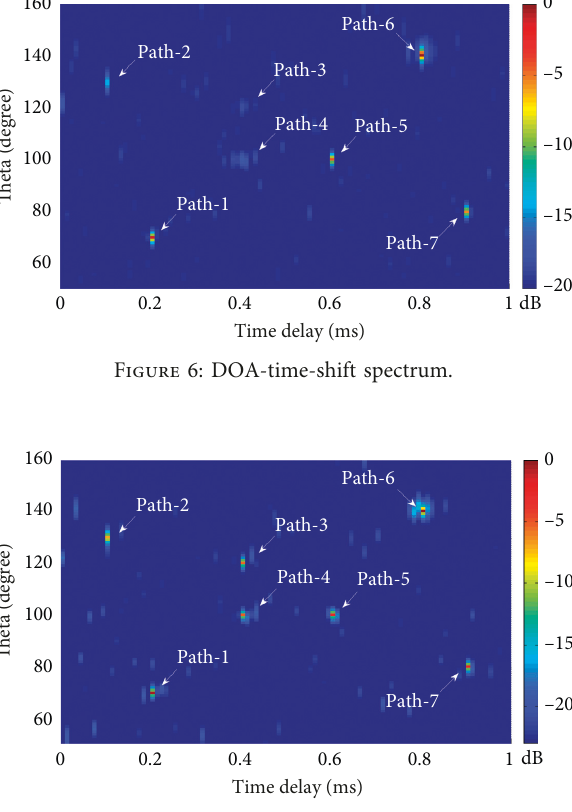
Figure 7: DOA-time-shift spectrum with spatial